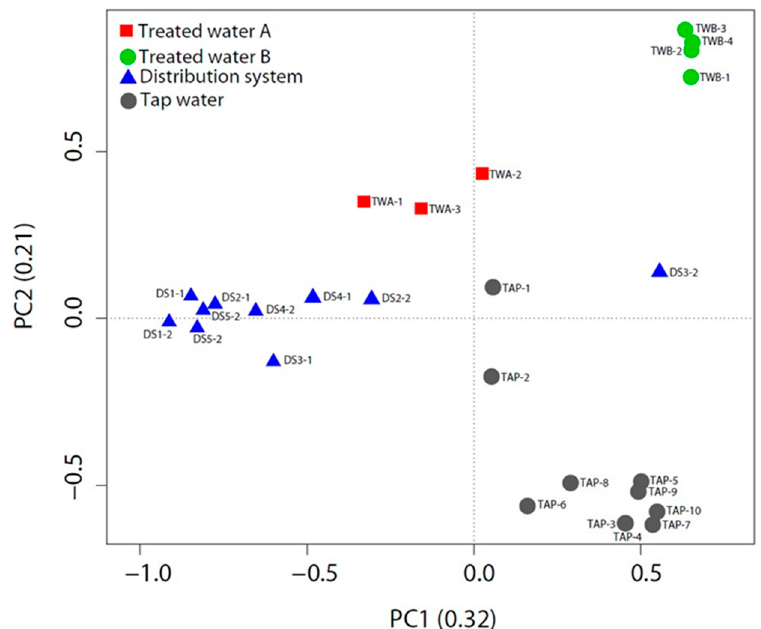
Figure 4. Ordination plot of principal component analysis (PCA) showing distribution of samples. Samples that cluster more closely together share a greater similarity structure. Axes PC1 and PC2 explained 53% of the variability in the data.